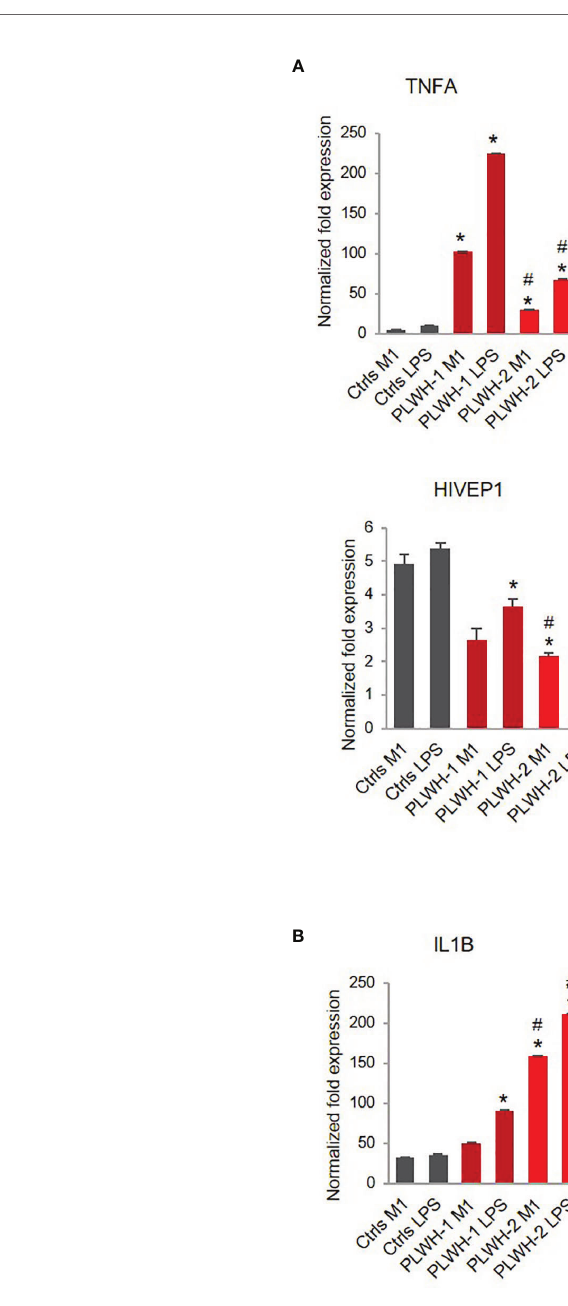
FIGURE 6 | Strati fi cation of PLWH-derived samples based on TNFA and IL6 expression levels. Bar graphs indicate mRNA expression levels of TNFA , IL6 , HIVEP1 , NCOR2 (A) and IL1B (B) in controls (n=10), PLWH subgroup 1 (PLWH-1, n=7), and PLWH subgroup 2 (PLWH-2, n=18). *Indicates statistical signi fi cance between PLWH (1 or 2) and controls, while # indicates statistical signi fi cance between PLWH-1 and